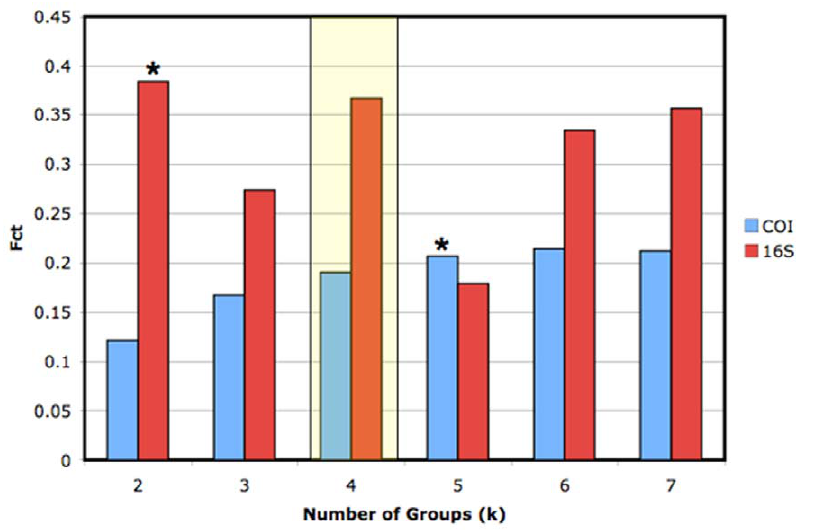
Figure 3. Values of F CT for alternative numbers of groups in SAMOVA for COI and 16S. * indicates the maximal F CT groupings based on the COI and 16S data, while the shaded region delineates the structure expected from hydrodynamic models of larval dispersal in the